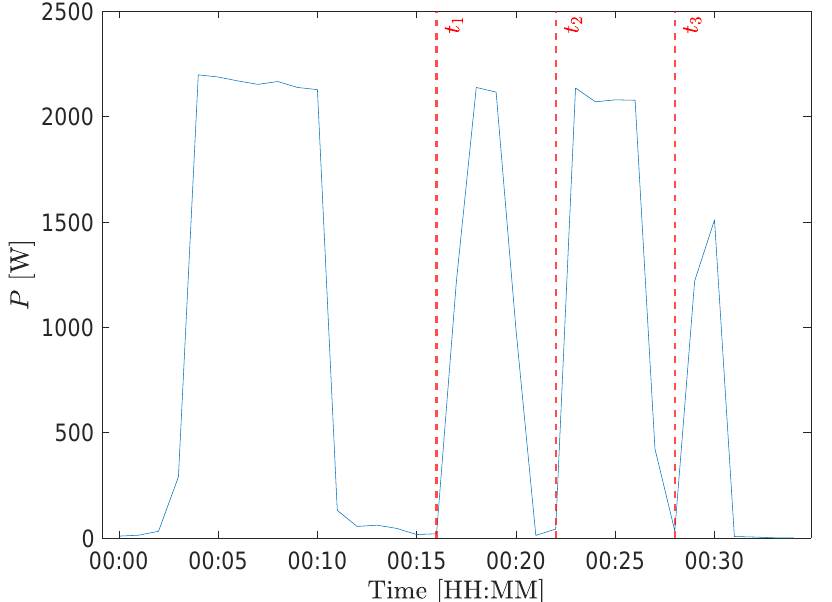
Figure 7. Profile of an exemplary washing machine.